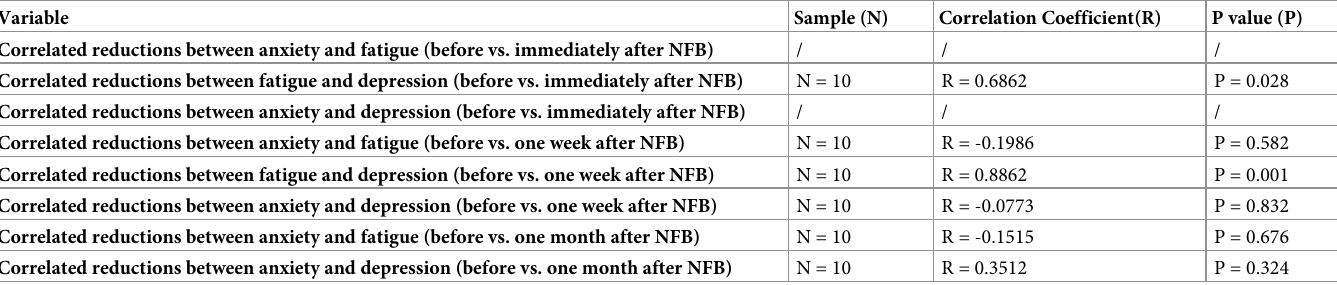
Abbreviation N stands for number of participants used for the particular analysis. Abbreviation R stands for Correlation Coefficient. Abbreviation P indicates value. The symbol ,,/,, indicates no measurement was